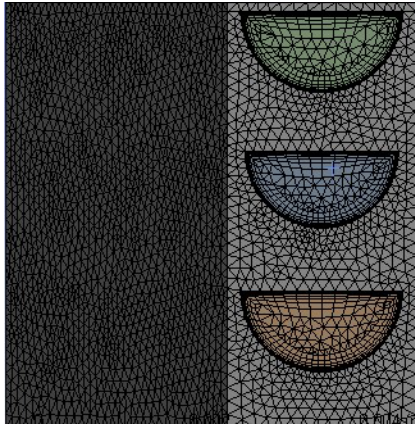
Figure 4. The structured mesh of the computational domain. Table 3. Mesh independence analysis for channel configurations of the PCHE (temperature at the cold channel outlet).